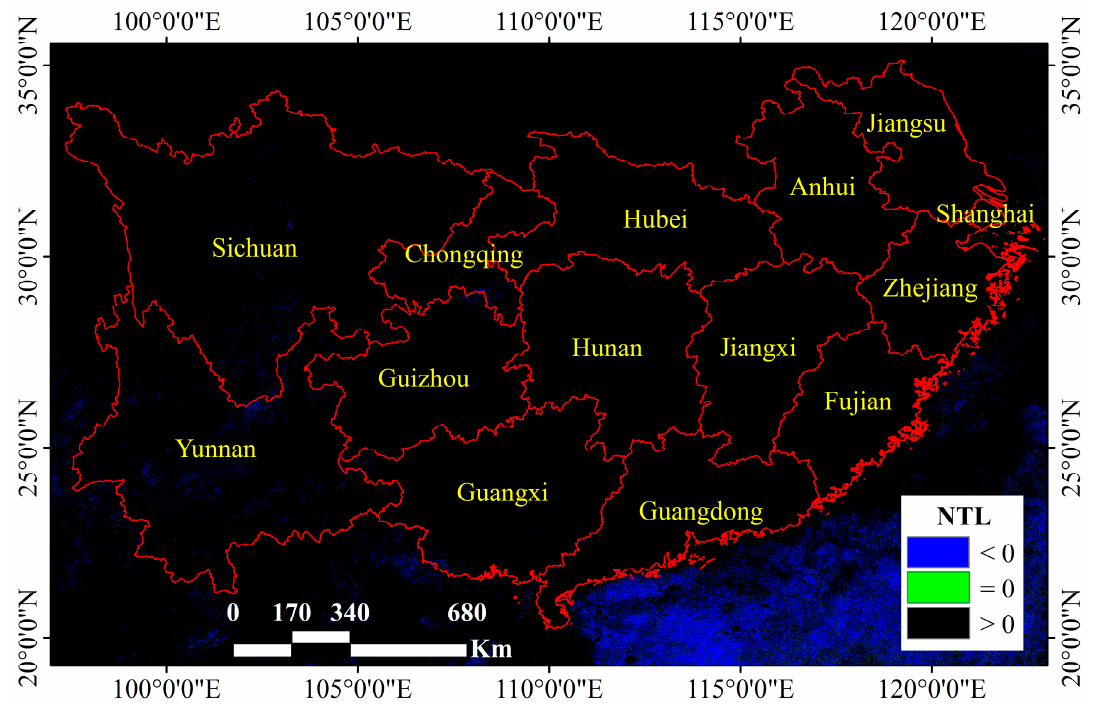
Figure 4. NTL of study area in June 2014 after gap